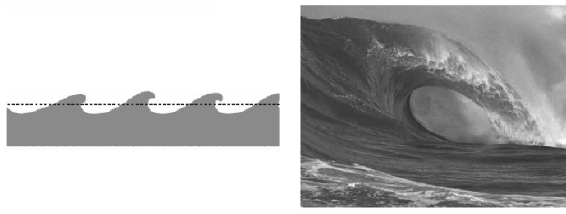
Fig. 8. The formation of surf waves in the presence of wind blowing parallel to the surface of the water on the left, the right shows a photo of the coastal wave, which is in fact the CSACE